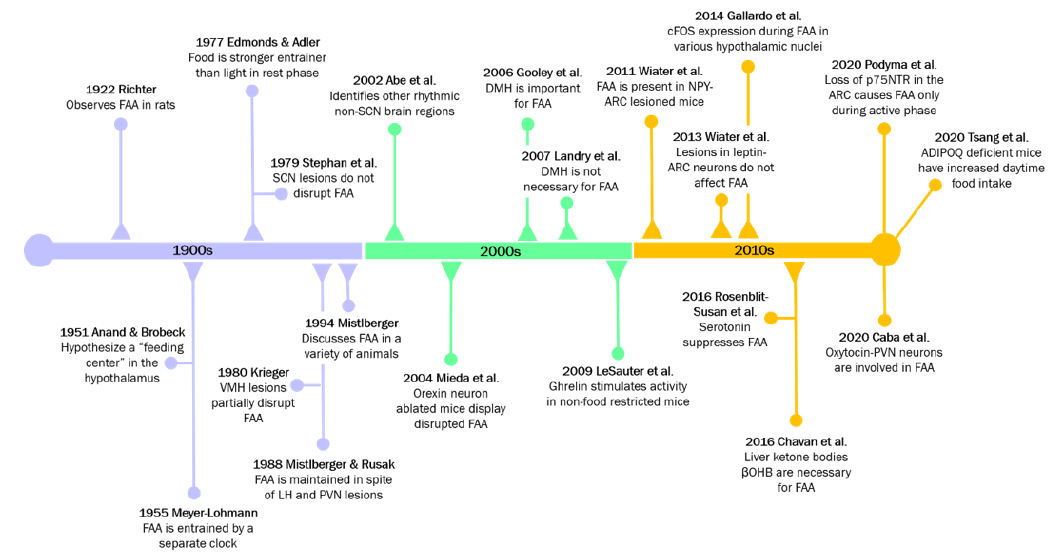
Figure 3. Tracking the “food-entrainable oscillator” through time.